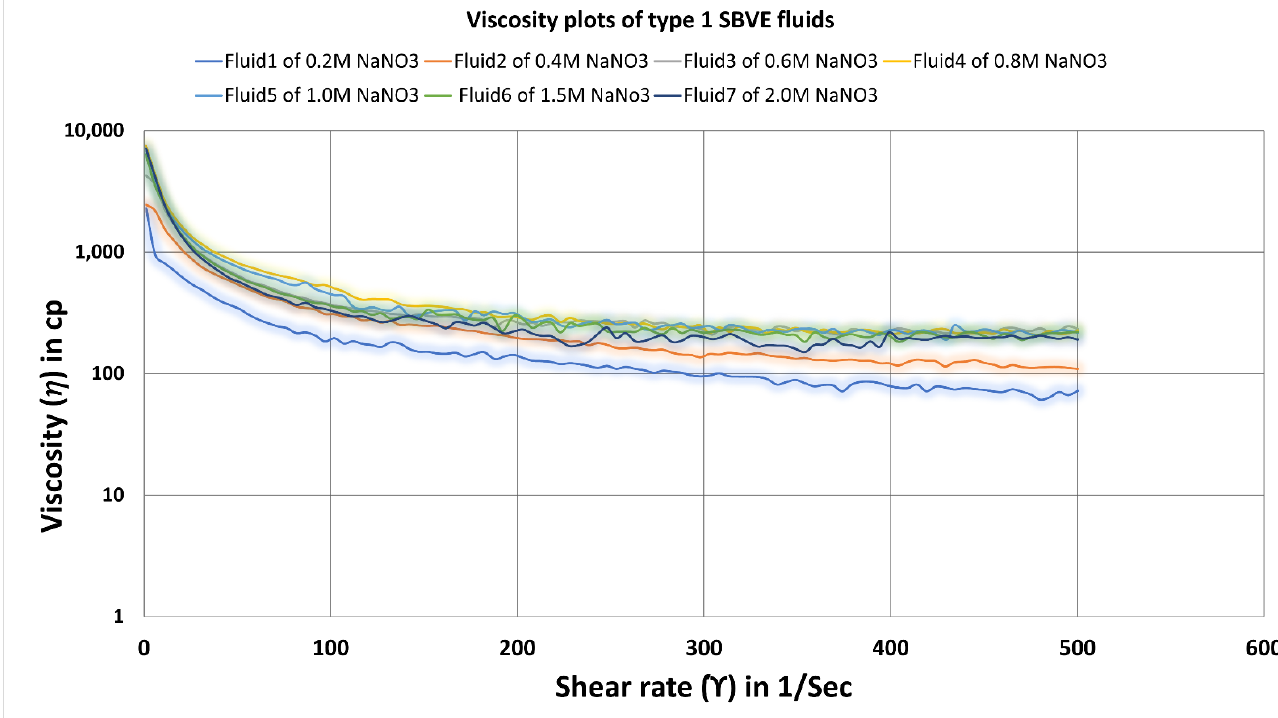
Figure 4. Viscosity curves for SBVE fluids of type1 category with varying NaNO 3 concentration at 25 °C.